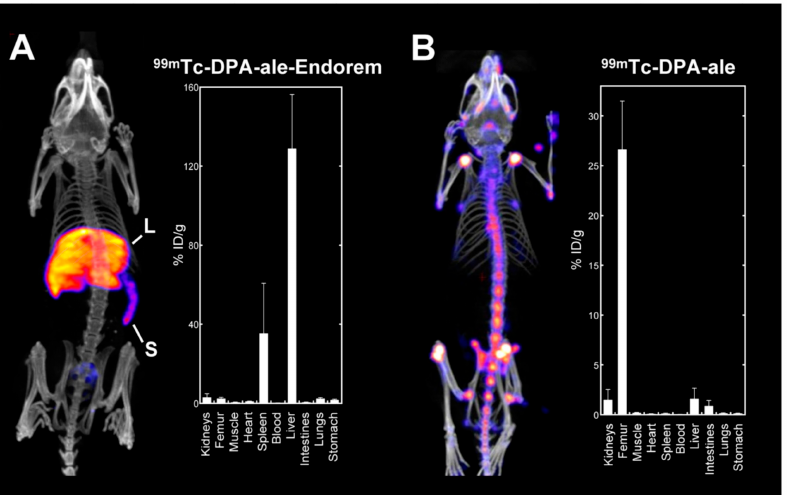
Figure 1. Whole body SPECT-CT imaging ( left ) and biodistribution studies ( right ) of 99m Tc-DPA-ale-Endorem ( A ) and 99m Tc-DPA-ale ( B ); the accumulation of both agents in the organs of healthy mice is expressed as the percentage of injected dose per gram of tissue (% ID/g). For each organ, the % ID/g represents the mean value ± standard deviation of n = 3 mice (L: liver, S: spleen). (Reprinted with permission from [34]. Copyright 2011 American Chemical Society).